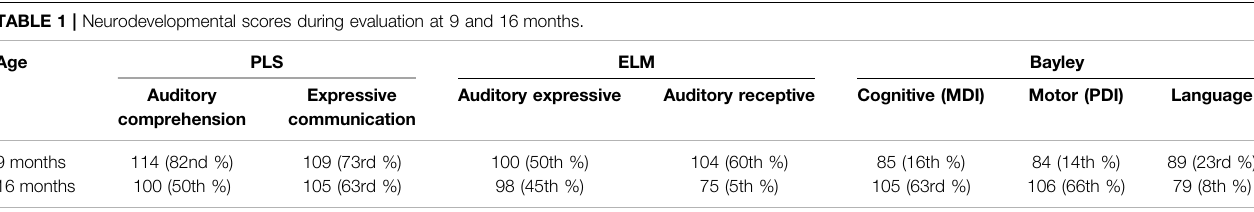
TABLE 1 | Neurodevelopmental scores during evaluation at 9 and 16 months.